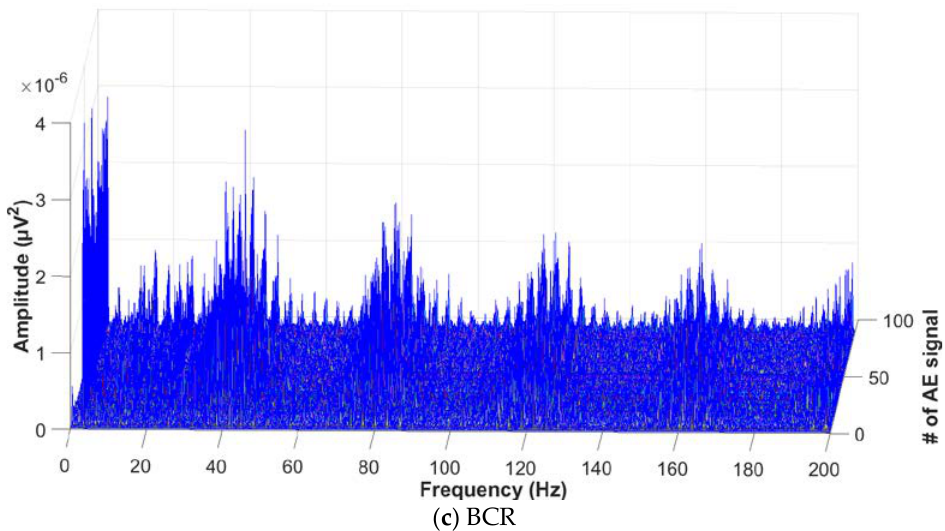
Figure 7. The EPS signals representing the bearing defect conditions of ( a ) BCO, ( b ) BCI, and ( c ) BCR obtained from the optimal sub-bands used for detection.